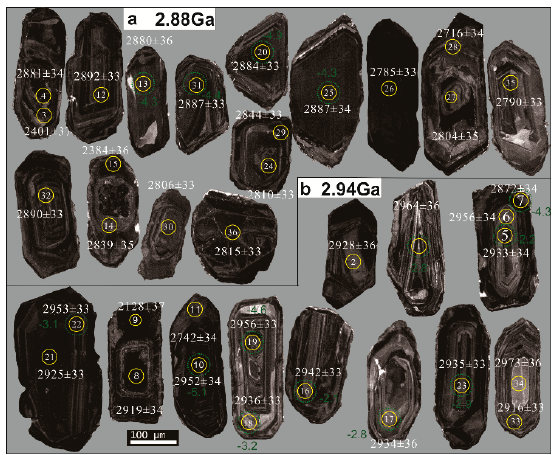
Figure 10. Representative cathodoluminescence images of zircons from the granite dike (D0002-4). Symbols are as in Figure 4. ( a ) Magmatic zircons with crystallization age; ( b ) Inheritance of zircons with metamorphic age.